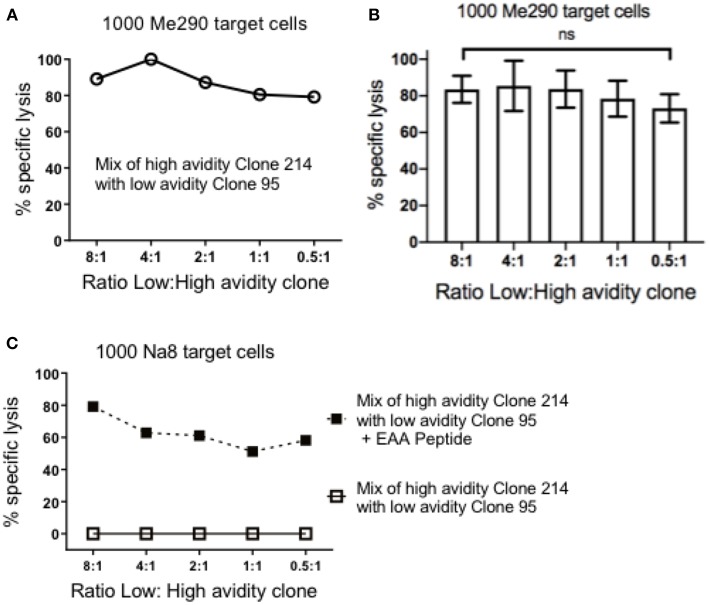
Pre-incubation of target cells with the low avidity T cell clones did not inhibit the cytotoxicity of the high avidity T cell clones. (A) At the constant concentration of 1,000 target cells in every well, different numbers of low avidity T cells (clone 95) were pre-incubated for 1.5 h with Me290 melanoma target cells (without synthetic peptide). Subsequently, the high avidity T cells (clone 214) was added in the following cell numbers (ratios) of low avidity clone: high avidity clone, at 80.000:10.000 (8:1), 40.000:10.000 (4:1), 20.000:10.000 (2:1), 10.000:10.000 (1:1), 5.000:10.000 (0.5:1), and incubated for further 3 h to determine specific lysis as described in the methods section. (B) Average ± standard deviation of three independent assays. No statistically significant differences were detected (One-way Anova). (C) Control experiment with the Melan-A negative melanoma cell line Na8, with and without the addition of synthetic Melan-A peptide (“EAA”; EAAGIGILTV) at the concentration of 1 μM, showing results that are representative for two experiments.